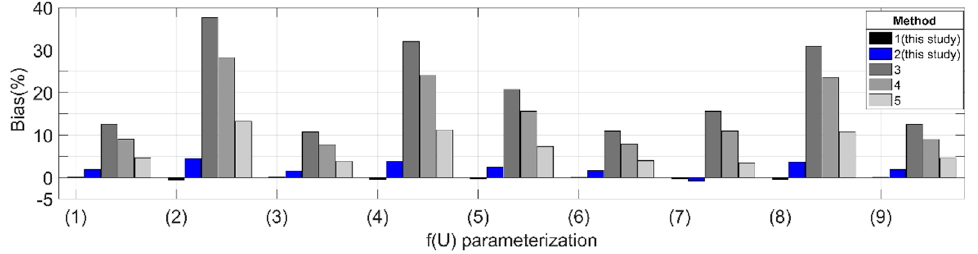
Figure 5. Difference in 6-hourly k and corrected k for CO 2 applying five correction methodologies in reference to the 6-hourly k (in %) for k parameterizations listed in Table 1. The bias is estimated as △ k*100/k 6h,0.5° .